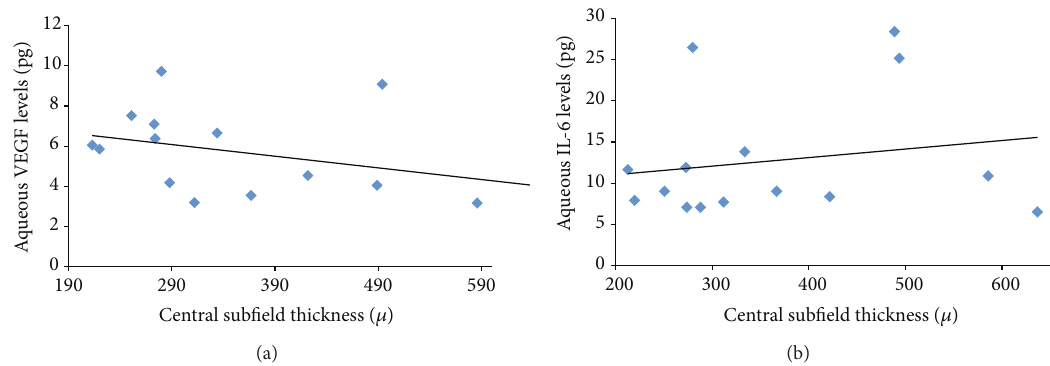
Figure 4: Correlation plot showing correlation between aqueous VEGF (a) and aqueous IL-6 levels (b) with central subfield thickness on Spectralis OCT in patients in group 1.